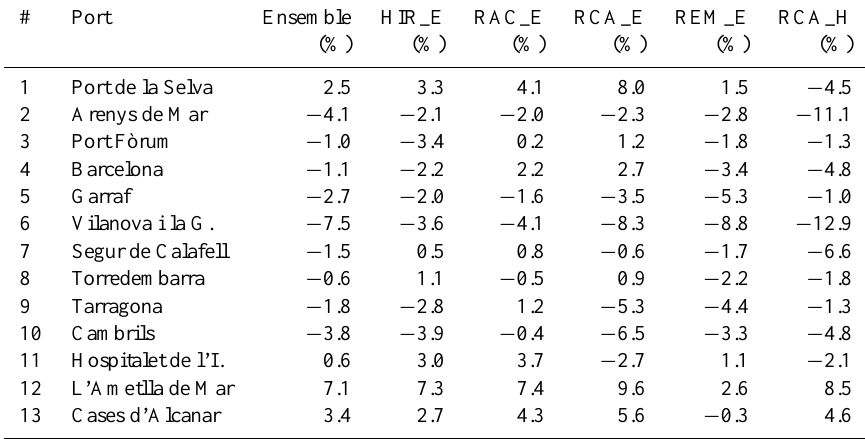
Table 3. Projected change (future minus present in %) of the spatial averaged H s at the 13 studied ports. # Port Ensemble HIR_E RAC_E RCA_E REM_E RCA_H (%) (%) (%) Port de la Selva Arenys de